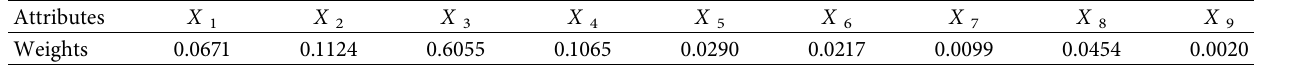
Table 9: Weights of attributes using entropy method.